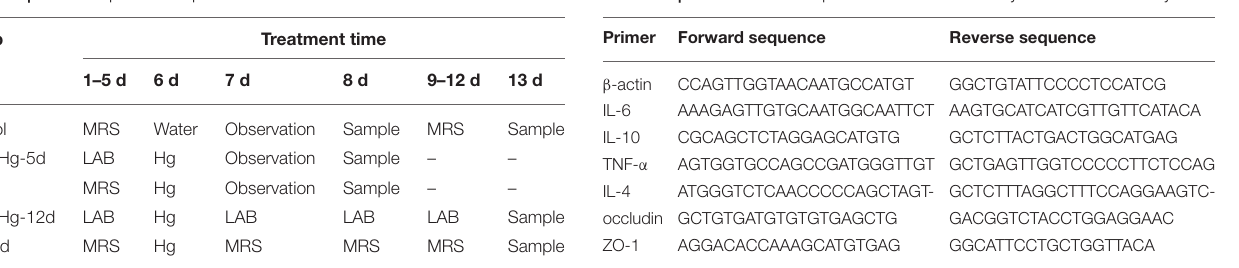
TABLE 2 | Primers used for q-RT PCR for inflammatory and functional